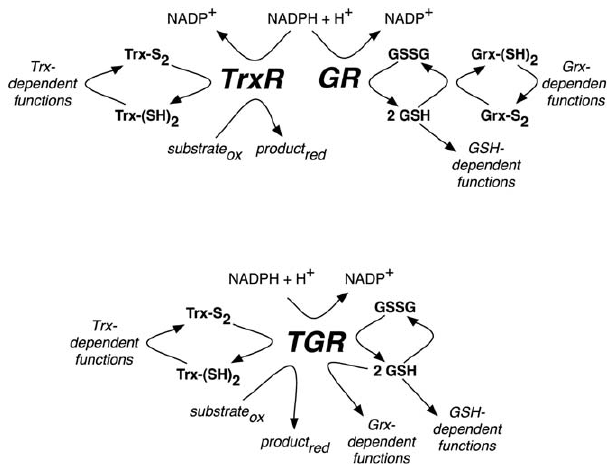
Figure 1. Redox Pathways in Mammals and S. mansoni In mammals (upper pathway), electrons from NADPH are transferred to an oxidoreductase flavoenzyme, either thioredoxin reductase (TrxR) or glutathione reductase (GR). Electrons are then transferred from the oxidoreductase flavoenzyme to the appropriate electron carrier, either oxidized thioredoxin (Trx-S 2 ) or glutathione disulfide (GSSG) converting them to reduced thioredoxin (Trx-[SH] 2 ) or glutathione (GSH), respec- tively. Trx-(SH) 2 and GSH then supply reducing equivalents for a number of different reactions, including those that are glutaredoxin (Grx)- dependent. In S. mansoni (lower pathway), TrxR and GR are replaced with a unique oxidoreductase flavoenzyme, TGR, which provides reducing equivalents for Trx-, GSH- and Grx-dependent reactions.